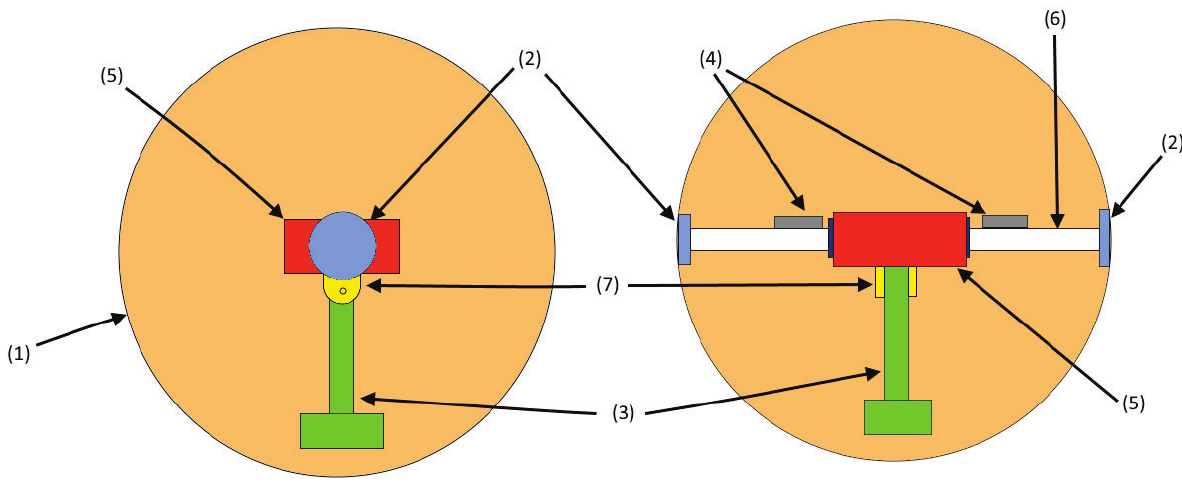
Figure 2. Details of the spherical